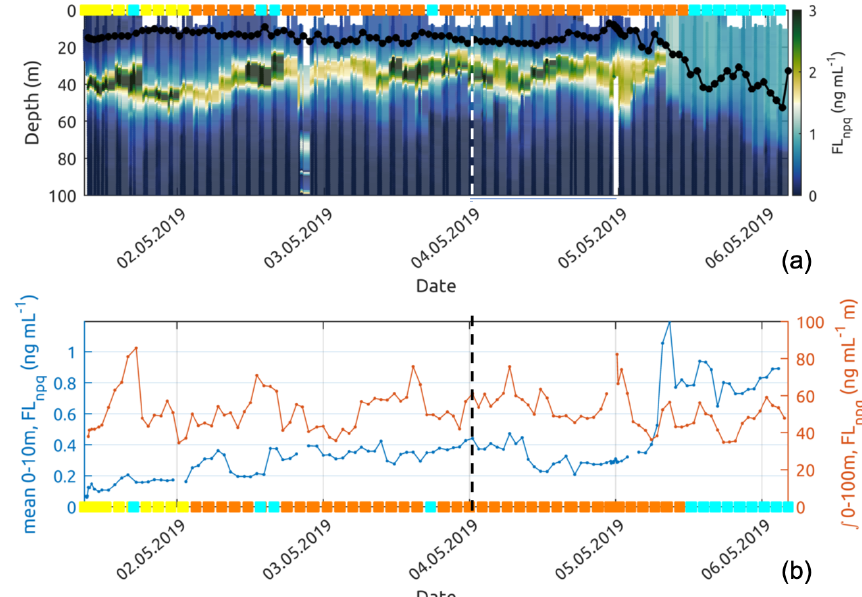
Figure 12. Panel (a) shows the fluorescence observed by the glider and corrected using non-photochemical quenching following Xing et al. (2012). The black line with dots shows the mixed-layer depth (MLD) for each glider profile. Panel (b) presents the near-surface (0–10m average) Chl- a fluorescence concentration and the Chl- a fluorescence concentration integrated over 0–100m along the glider track. The coloured squares correspond to the dominant water mass (according to Fig. 7) observed at 10m depth by the glider. On both plots, the dashed vertical lines represent the time separating the descending and ascending